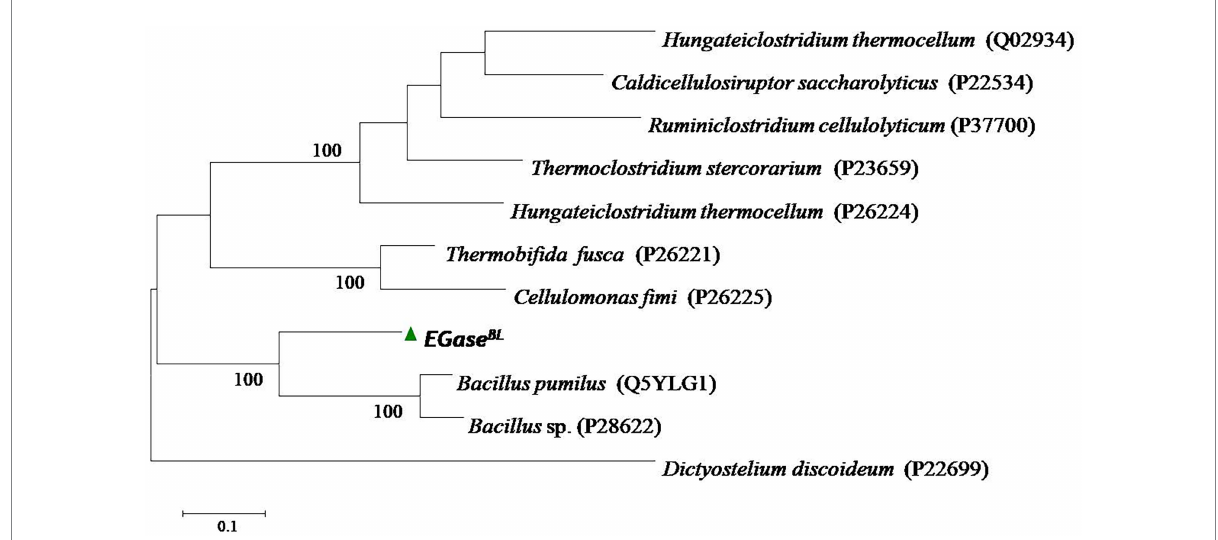
FIGURE 1 The phylogenetic analysis of the protein sequence of β -1,4-glucanase (EGase BL ) of Bacillus sp. PCH94 with the closest matches in the Protein Data Bank (PDB) database.